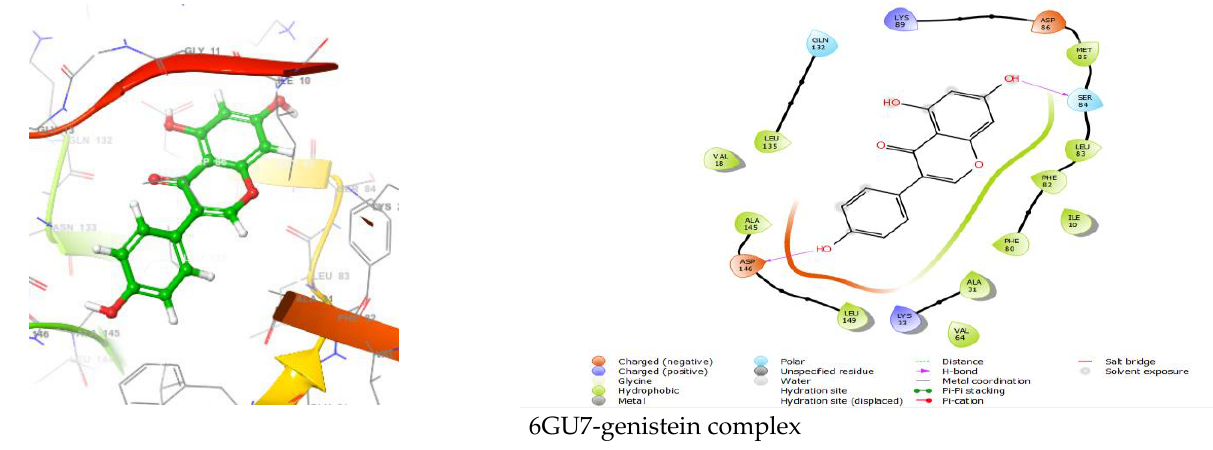
Figure 2. Interactions of 6GU7 with curcumin, quercetin, withanolide, and genistein.